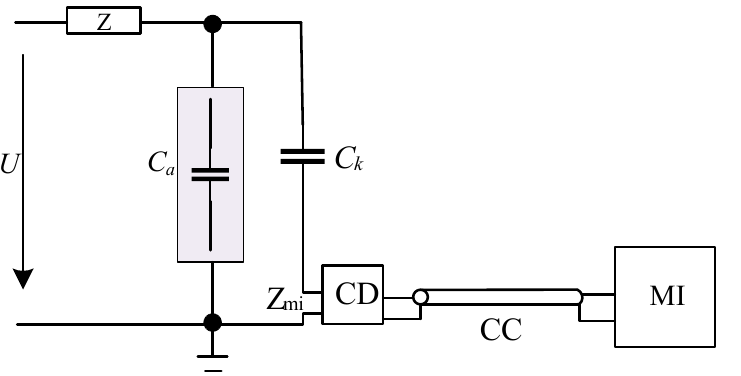
Figure 4. Schematic of the partial discharge test circuit.